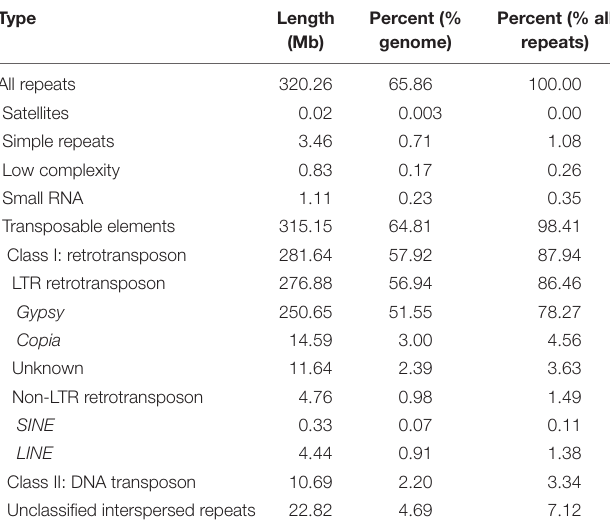
TABLE 1 | Statistics of repeats contents in the T. arvense